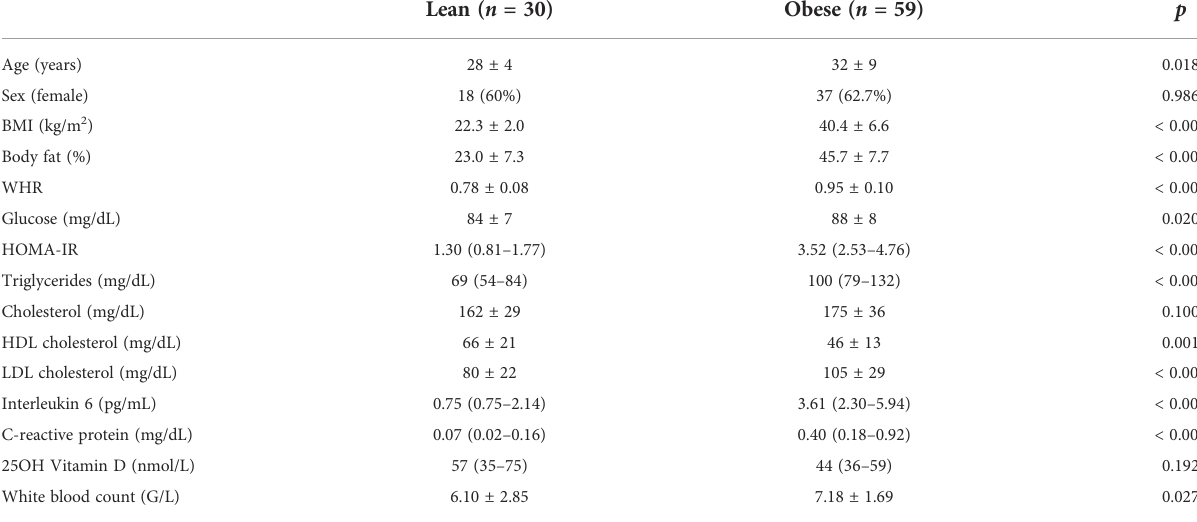
TABLE 1 Patients ’ characteristics strati fi ed by weight